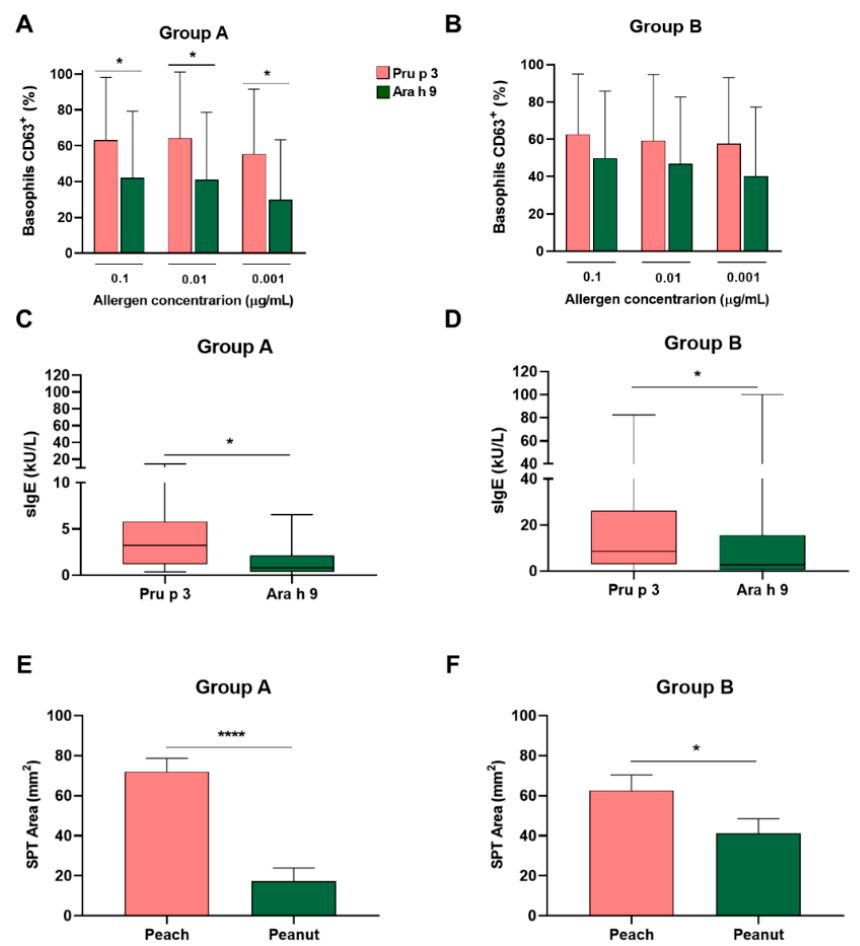
Figure 9. BAT is able to differentiate peanut tolerance. Percentage of basophils CD63 + was compared between BAT performed with Pru p 3 and Ara h 9 in patients with peach allergy and peanut tolerance (Group A) ( A ) and in individuals allergic to peach and peanut (Group B) ( B ), showing higher levels when BAT was made with Pru p 3. In addition, levels of in vitro sIgE to Pru p 3 and Ara h 9 were compared in Group A ( C ) and Group B ( D ), showing significantly higher levels of sIgE to Pru p 3 in both groups. Likewise, the wheal area from SPT performed with peach enriched with Pru p 3 and peanut extracts was compared in Group A ( E ) and in Group B ( F ), showing a higher area of wheal to peach extract in both groups. * p < 0.05; **** p < 0.0001. All these data could indicate that BAT, using CD63 as an activation marker, shows a lower reactivity to its corresponding LTP, Ara h 9, in peanut-tolerant